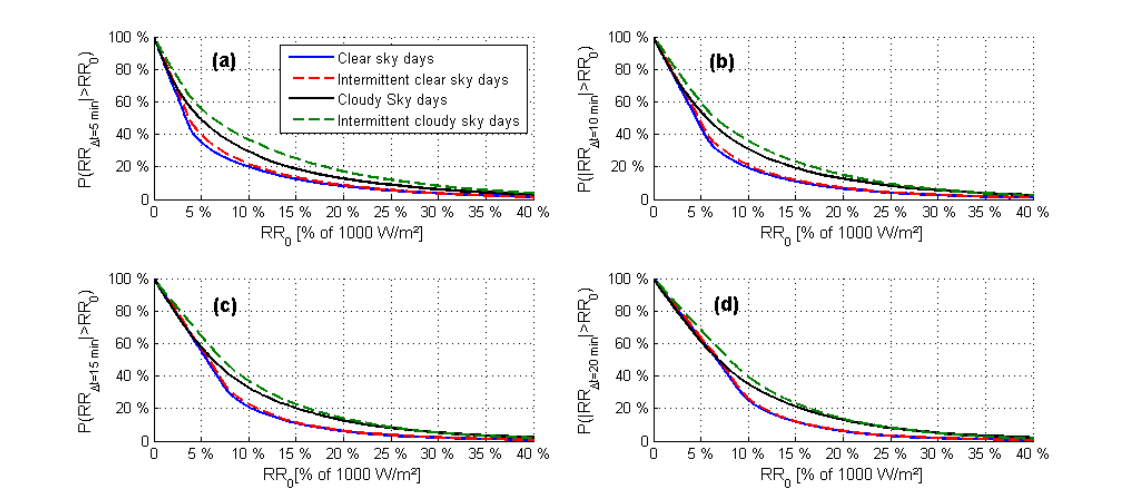
Figure 14. Cumulative distribution of GHI ramp rate for: ∆ t = 5 min ( a ); ∆ t = 10 min ( b ); ∆ t = 15 min ( c ); and ∆ t = 20 min ( d ).